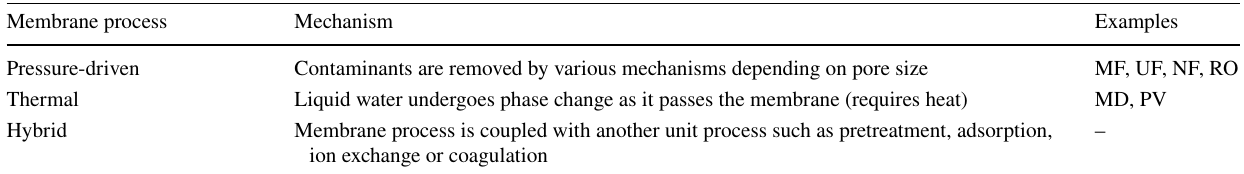
Table 2 Various membrane processes for water treatment